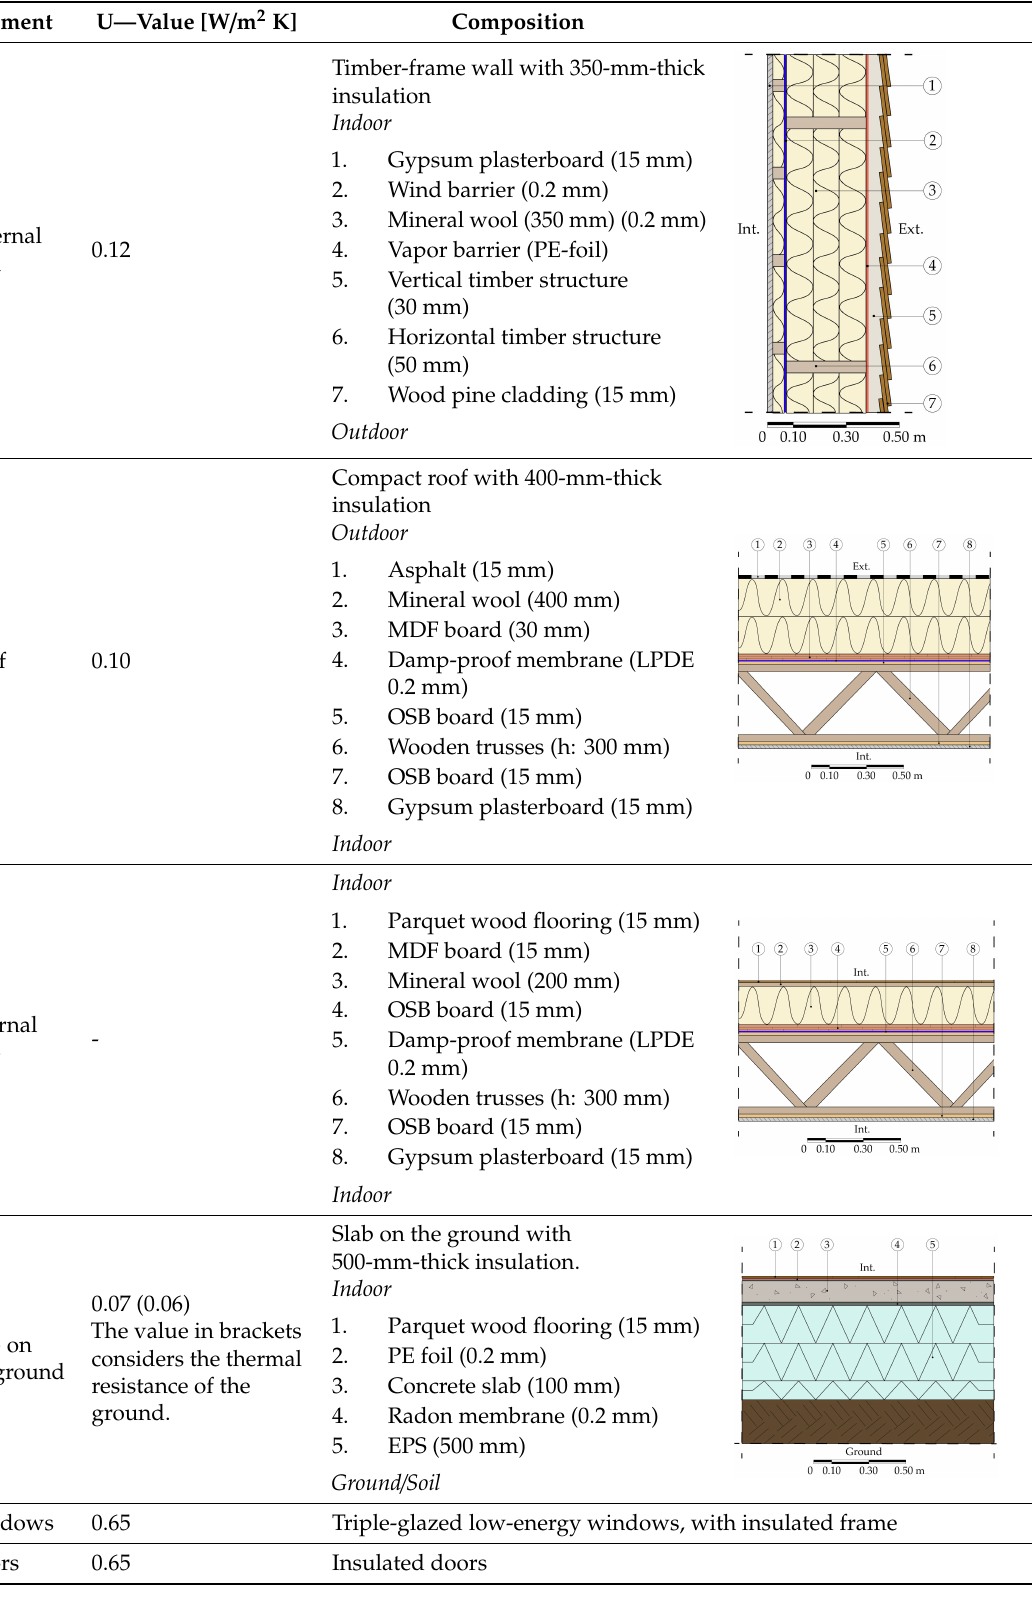
Table 6. Thermal transmittance value (U-value) of the di ff erent building envelope components of the ZEB Base Case